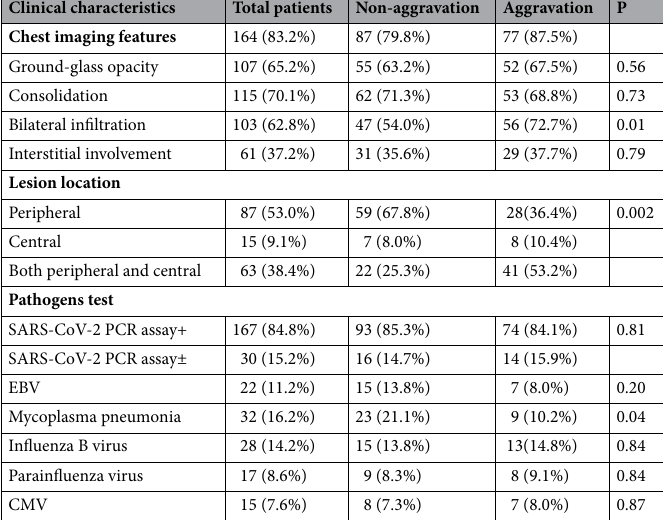
Table 5. Radiological data and pathogens test of the patients. Data are n (%).